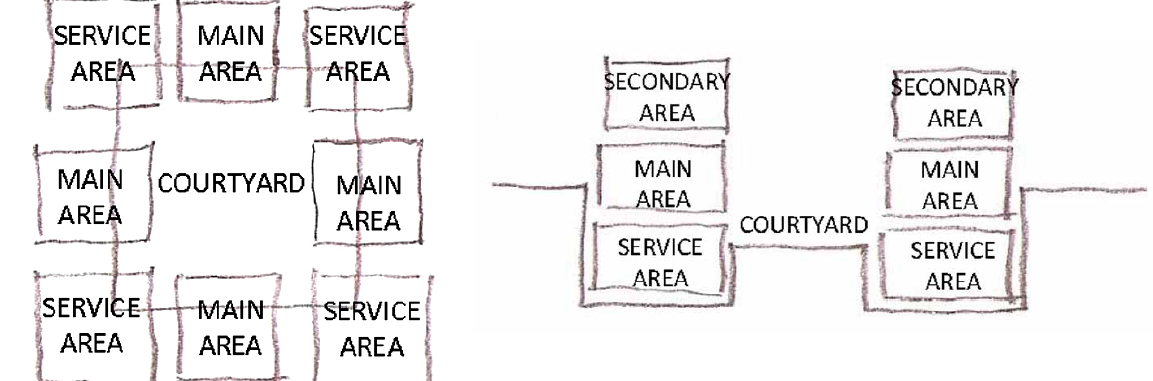
fig. 4b. a schematic section which shows arrangement of main areas, secondary areas and service areas in relation to the courtyard in a